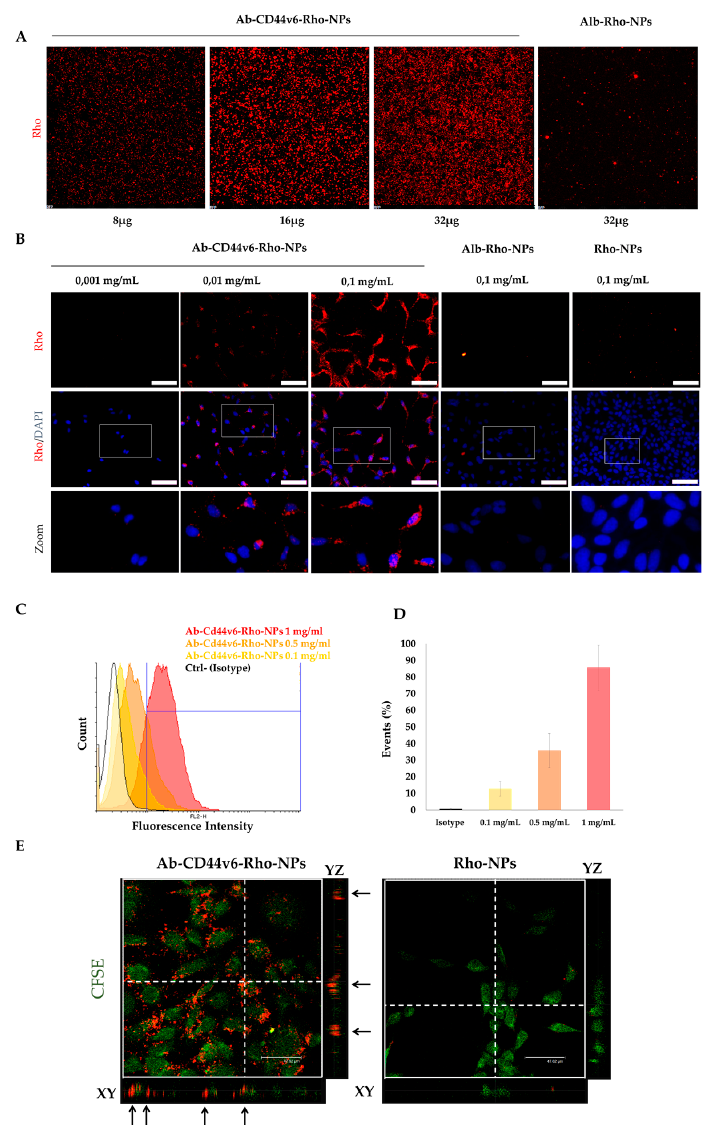
Figure 8. Binding and internalization of Ab-CD44v6-Rho-NPs in HEK-293A-CD44v6: ( A ) Concentration-dependent binding of Ab-CD44v6-Rho-NPs to HEK-293A-CD44v6. Cells were incubated with NPs for 1 h at room temperature (RT) and then washed multiple times to eliminate unbounded NPs; Rho signal (in red); magnification 10×. ( B) Up-take of different concentrations of Ab-CD44v6-Rho-NPs and of controls, human Albumin conjugated NPs (Alb-Rho-NPs), and unconjugated NPs (Rho-NPs) in HEK-293A-CD44v6; cells were incubated with NPs for 4 h at 37 °C and then washed multiple times to eliminate excess of NPs; DAPI (4 ′ ,6-diamidino-2-phenylindole) nuclear staining shown in blue, Rho signal in red; scale bars: 100 µm. ( C , D ) Analysis of cellular uptake of Ab-CD44v6-Rho-NPs in HEK-293A-CD44v6 by fluorescence-activated cells sorting (FACS). Cells were incubated with NPs for 4 h at 37 °C, washed multiple times, and fixed. Overlay of histograms ( C ) representative of different experiments performed with the Isotype (Rho-NPs) and different concentrations of Ab-CD44v6-Rho-NPs and ( D ) mean percentage of internalized NPs in HEK-293A-CD44v6: the results are shown for each concentration condition as mean percentage ±SD of experiments performed in triplicates. ( E ) Z-stack analysis of the internalization of Ab-CD44v6-Rho-NPs, compared to unconjugated Rho-NPs, in HEK-293A-CD44v6. A CFSE cell tracer was used to stain the cytoplasm (in green). Dotted lines represent the section in the axial plane corresponding to the frontal (XY) and sagittal (YZ) planes. Black arrows show Rho signal in correspondence to the CSFE signal in frontal and sagittal planes. Scale bars: 47.62 µm.